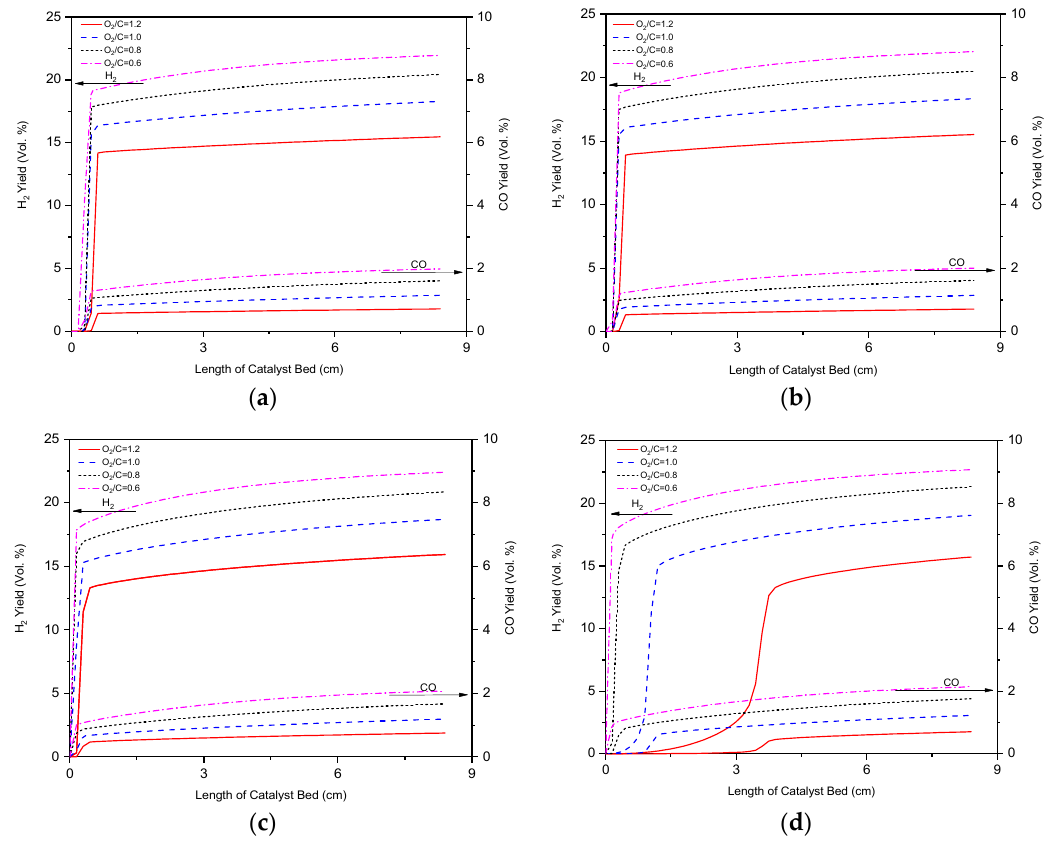
Figure 4. O 2 /C ratio conditions: 0.6, 0.8, 1.0 and 1.2 at different reaction temperatures: ( a ) 400 °C; ( b ) 450 °C; ( c ) 500 °C; ( d ) 550 °C.